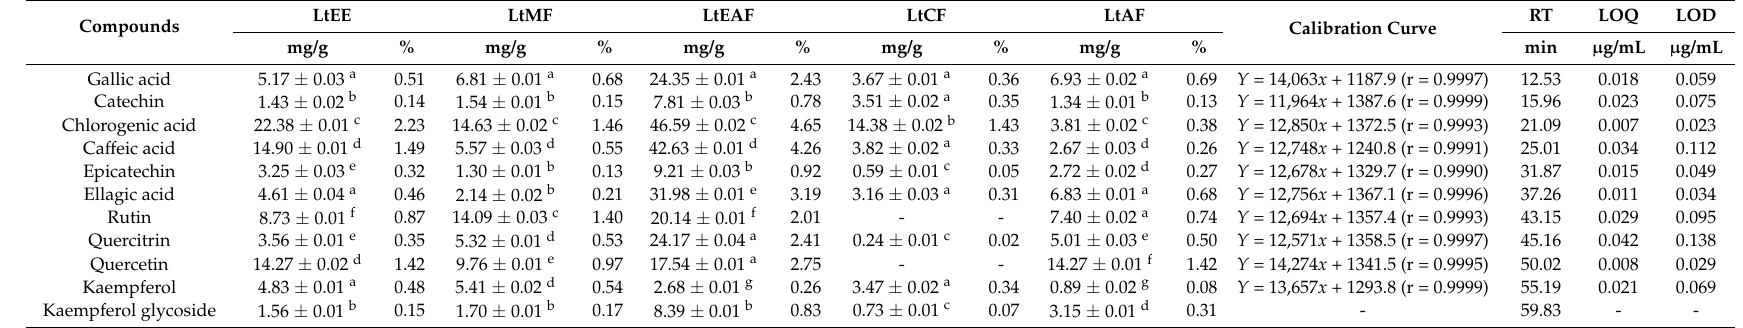
Table 4. Phenolics composition of Licania tomentosa by HPLC-DAD